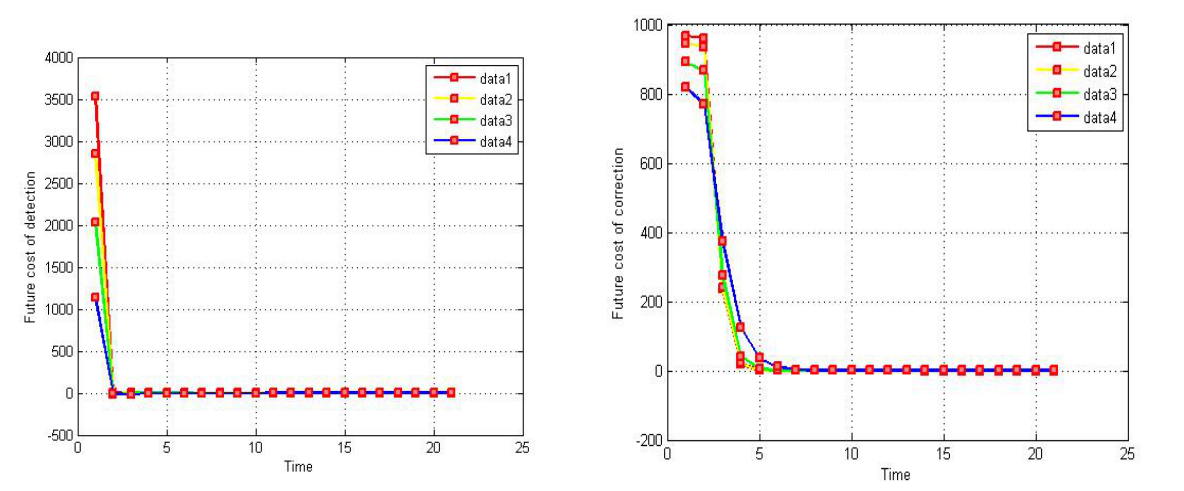
Fig. 3. Shadow cost for detection vs. time Fig. 4. Shadow cost for correction vs.